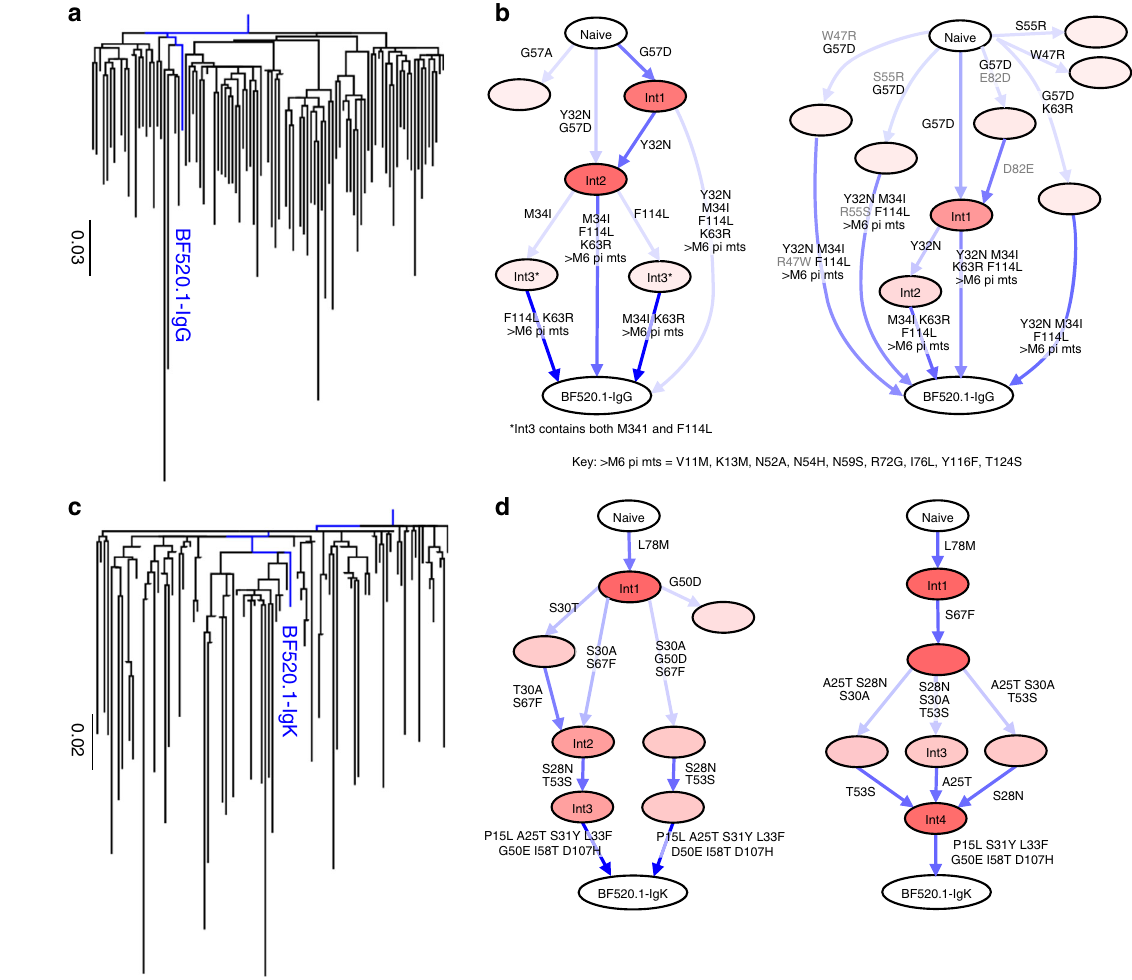
Fig. 1 Ontogeny of the infant-derived bnAb BF520.1. a , c Maximum likelihood phylogenetic relationships of a heavy- and c light-chain antibody gene variable regions. Trees display the inferred naive ancestor (root), BF520.1 from M12 pi (blue), and representative clonal family member next generation sequencing (NGS) reads from M6 pi (black). Units for branch length estimates are nucleotide substitutions per site. b , d Most probable routes of BF520.1 development: Bayesian BF520.1 clonal family phylogenies were sampled from an associated posterior distribution and then summarized to display relative con fi dences for internal node sequences. Resulting graphics display multiple possible lineages of amino acid transitions and their relative con fi dences for b heavy- and d light-chain development determined from two NGS technical replicates (left, right). Amino acid substitutions (arrows) connect the inferred naive sequence to the mature BF520.1 sequence via reconstructed ancestral intermediate sequences (nodes). Labeled nodes were chosen as the most probable Bayesian lineage intermediate sequences. The red shading of nodes is proportional to the posterior probability that this ancestral sequence was present in the lineage. For a given node, the blue shading across arrows arising from that node is proportional to the corresponding transition probability. Transient mutations are labeled in